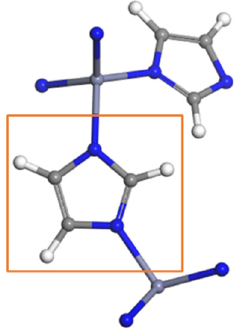
Figure 2. The structure of the imidazolate ligand. The ligand is shown within an orange box. As observed in the figure, the ligand may link with other carbon atoms through the N atoms. Color code: N—blue; C—gray; H—white.